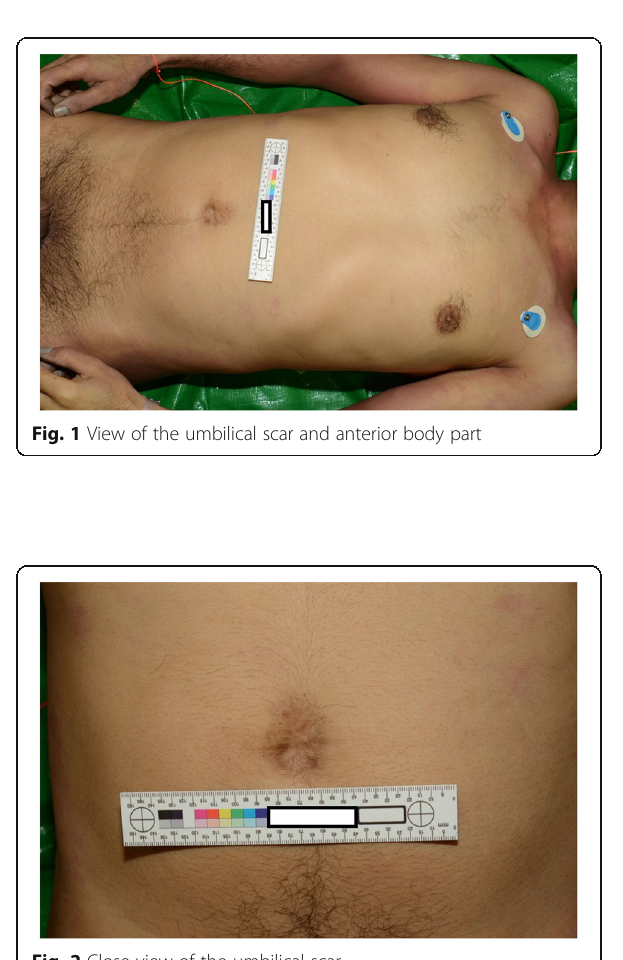
Fig. 4 Close view of the back